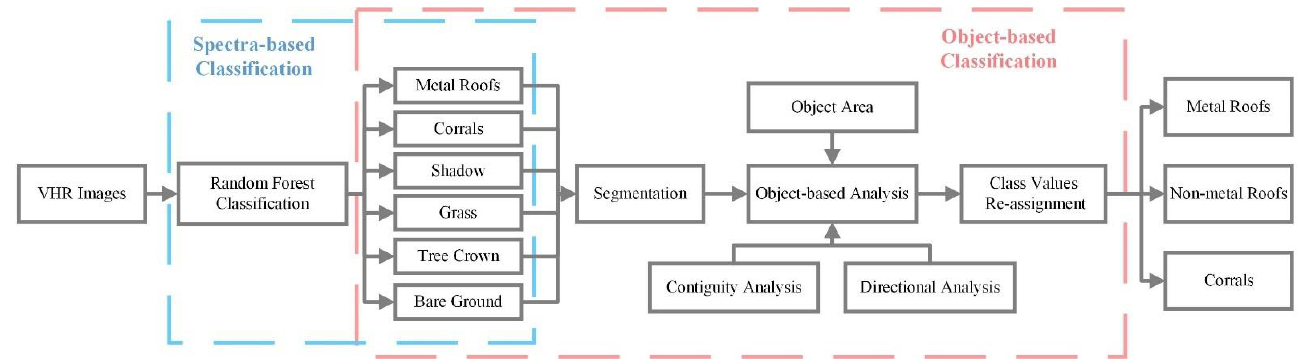
Figure 3. General workflow of the fused classification process for each of the VHR images. The blue and red boxes indicate the spectra- and object-based classification stages, respectively.